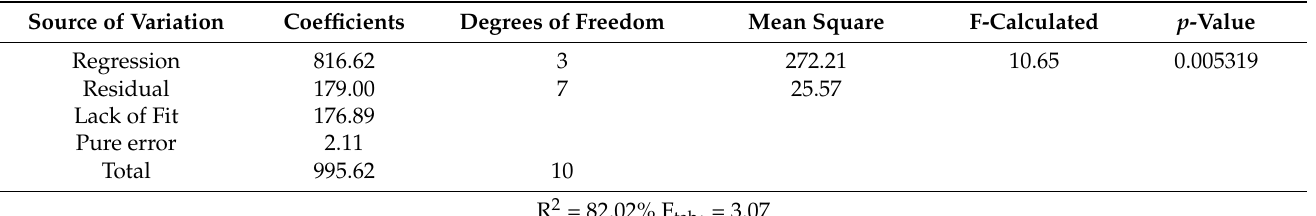
Table 2. ANOVA of the CCRD using statistically significant regression coefficients at 10% significance. Source of Variation Coefficients Degrees of Freedom Mean Square F-Calculated p